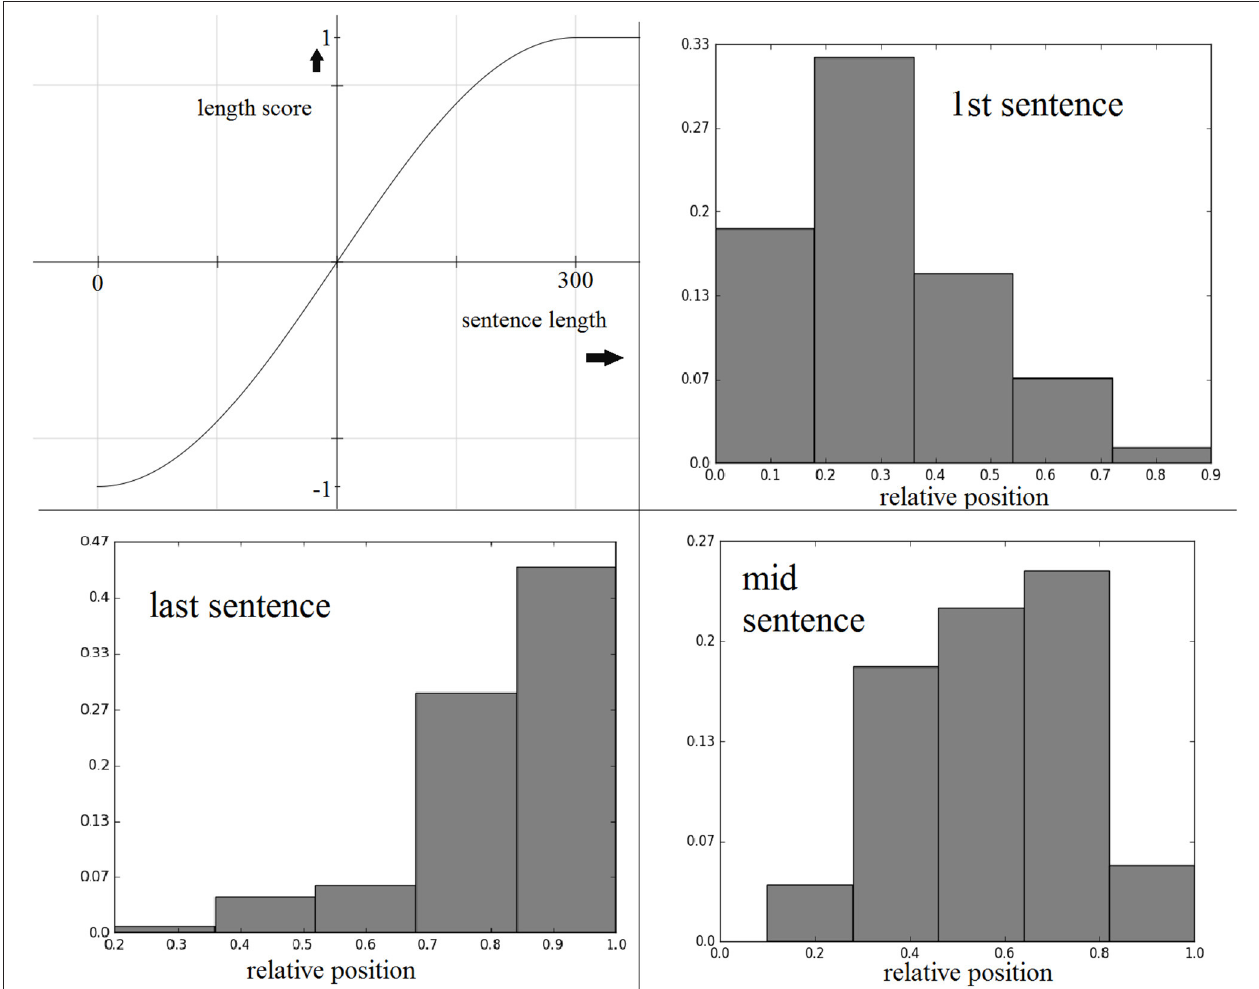
FIGURE 1 | Clockwise from top-left: sine function for sentence length score, maxed at 300 characters; first, middle, and last sentence relative position distributions from the best-scoring extractive training set summaries.